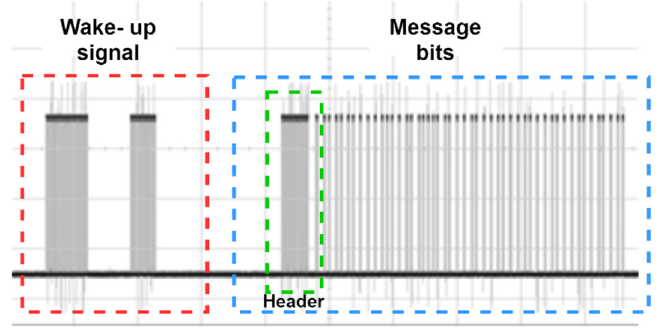
Figure 5. Oscilloscope capture of a designed data frame.